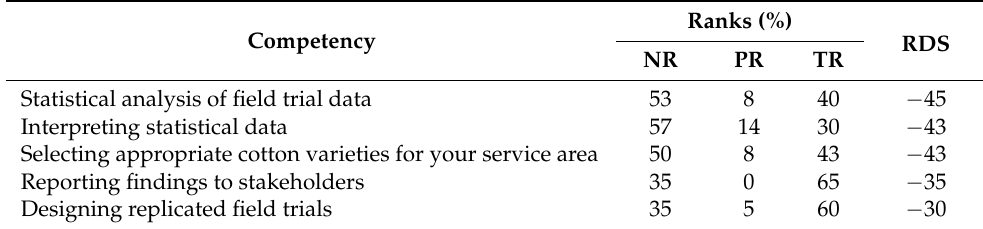
Table 8. Ranked Discrepancy Scores for individual competencies in applied research. Competency